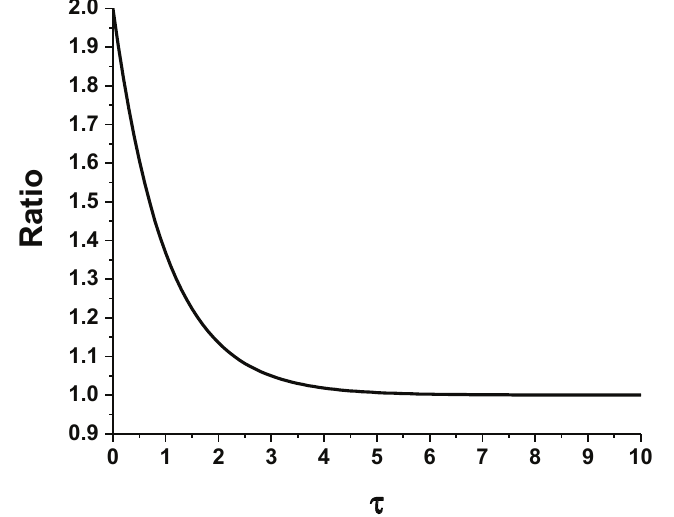
Figure 6. Relationship between optical depth, τ , and the ratio of a spectral line with its duplication compared to the line without